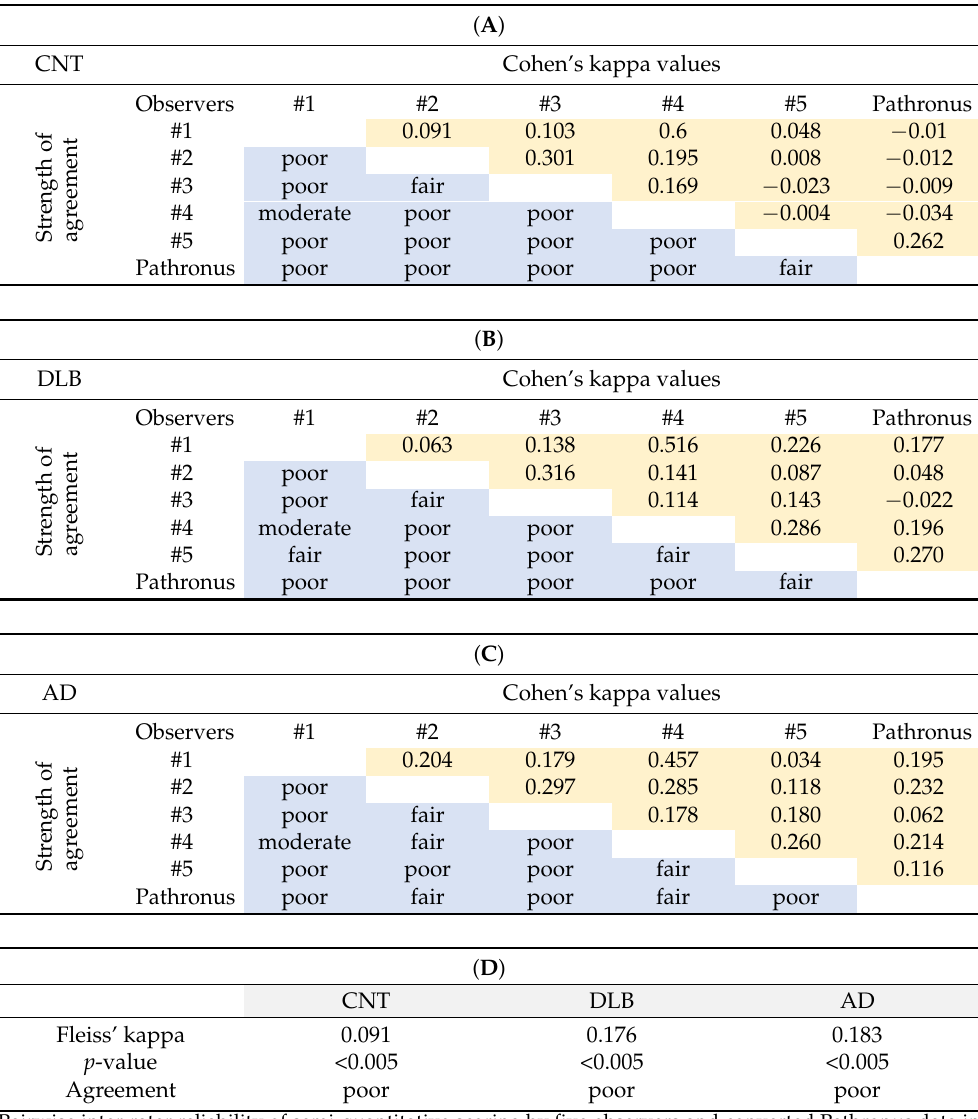
Table 2. Inter-rater